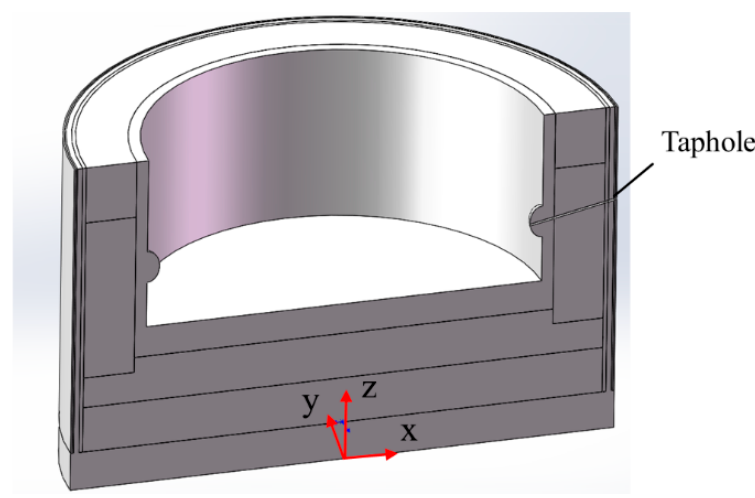
Figure 2. Schematic diagram of the 3-D simulated hearth structure of the WISCO No. 1 BF.